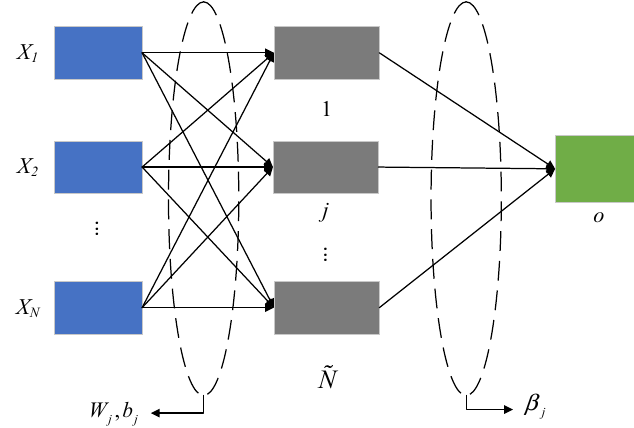
Figure 4. SVM system structure.